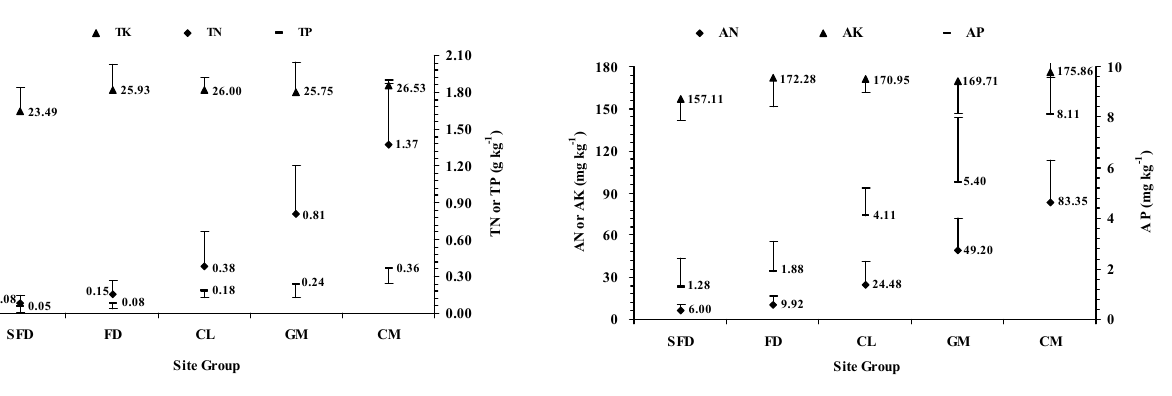
Fig. 7. The soil total N (TN), total P (TP), and total K (TK) of the study area. Values are means ± standard deviations. SFD stands for semi-fixed dune sites, FD for fixed dune sites, CL for cultivated land sites, GM for general meadow sites, and CM for control meadow sites where there was no detectable erosion and sand accumulation.